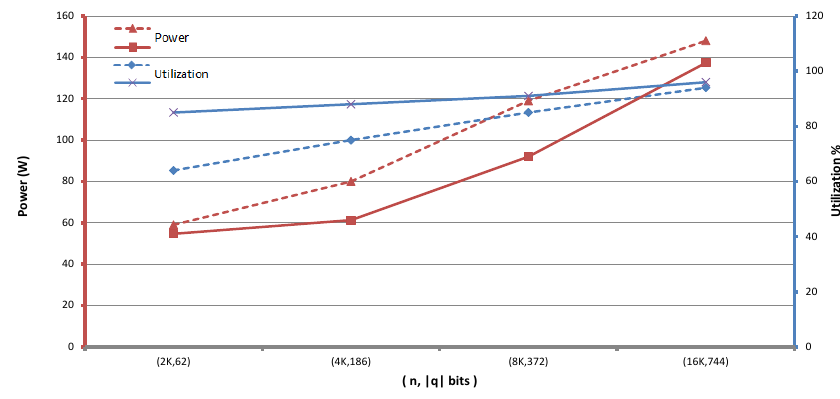
Figure 4: P100 (solid) and K80 (dashed) power consumption (W) and utilization rate for homomorphic multiplication of polynomials of degree < n with coefficients size | q | bits averaged over 10000